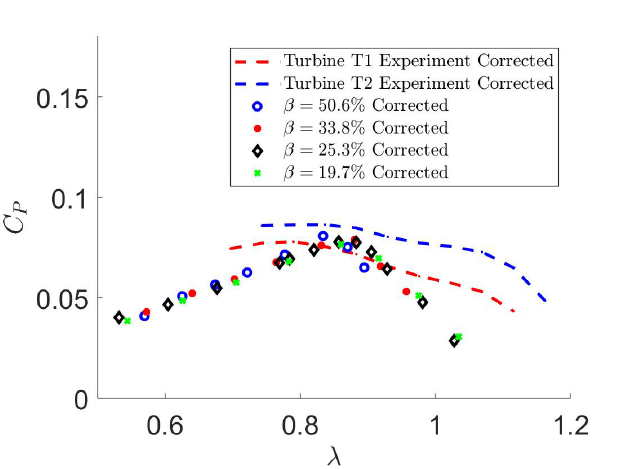
Figure 4. The numerically calculated and corrected power coefficient C P as a function of tip-speed- ratio λ . The purple dotted lines enclosed the interested points for later torque analyses.